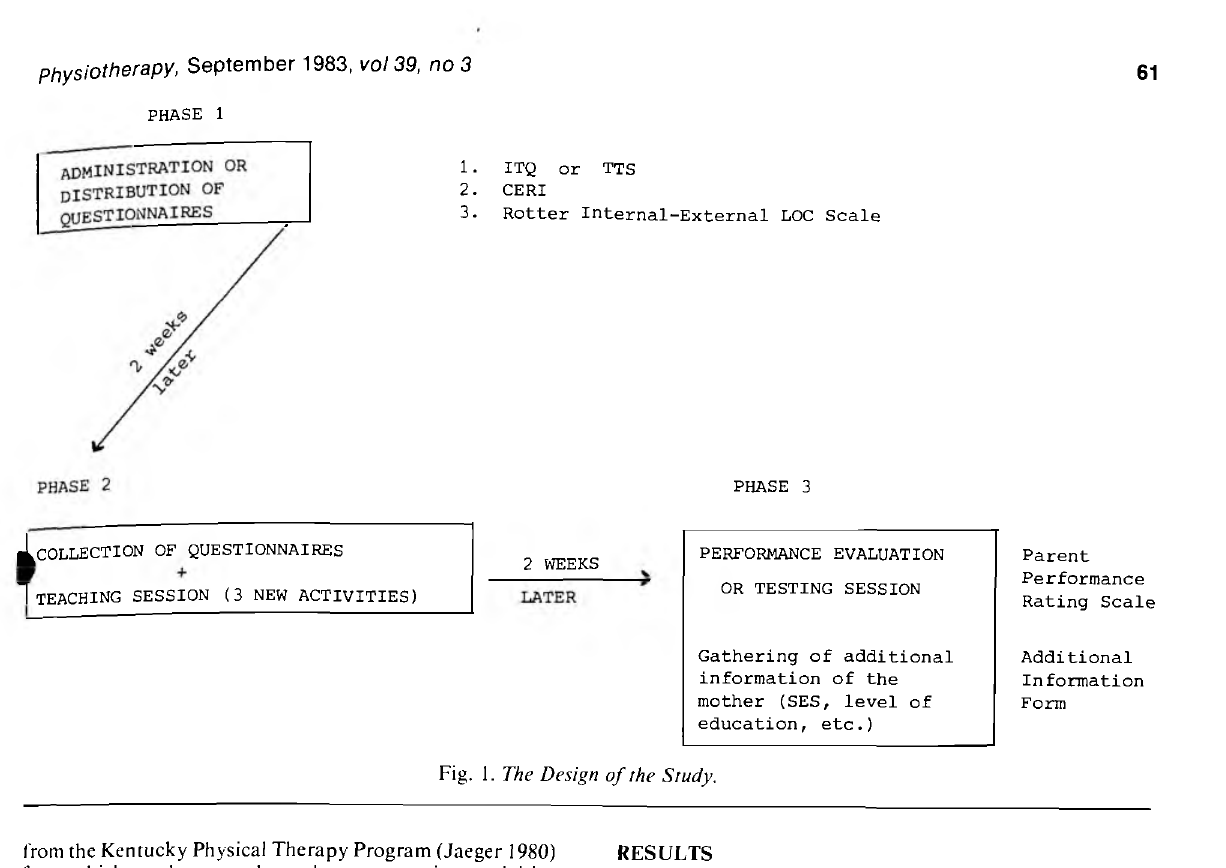
Fig. 1. The Design o f the Study.